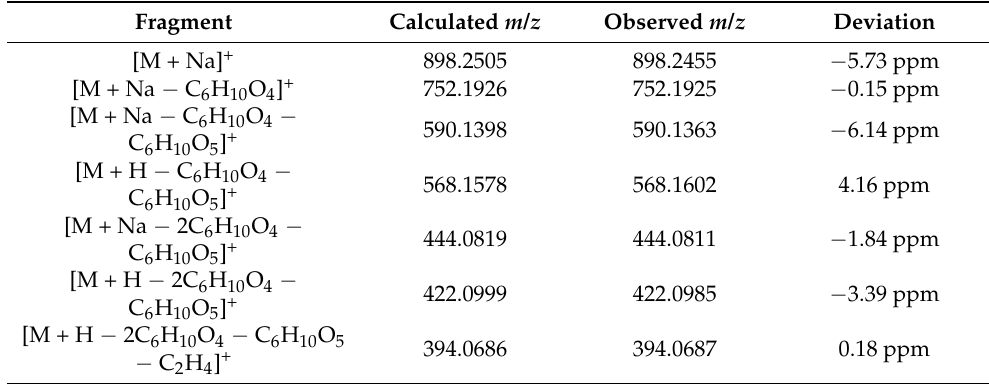
Table 4. The deviations between calculated and observed m / z values of each fragment derived from compound 4 .